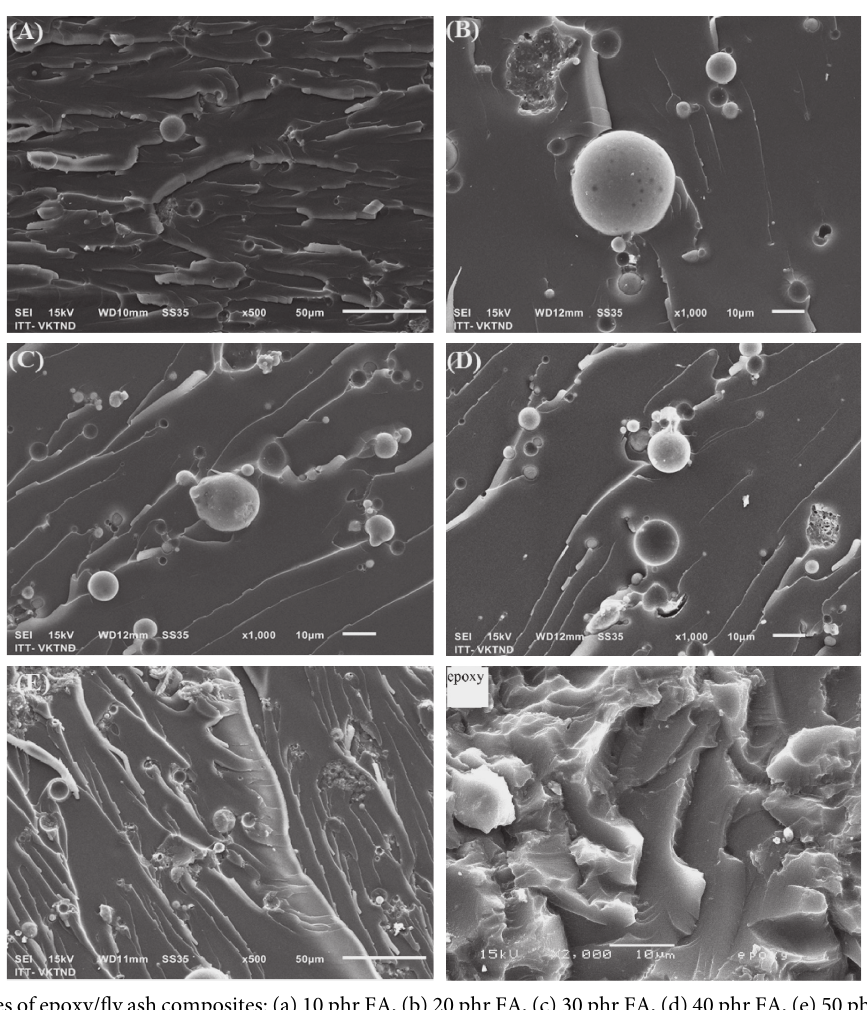
Figure 2: SEM images of epoxy/fly ash composites: (a) 10 phr FA, (b) 20 phr FA, (c) 30 phr FA, (d) 40 phr FA, (e) 50 phr FA, and (f) (epoxy) neat epoxy.